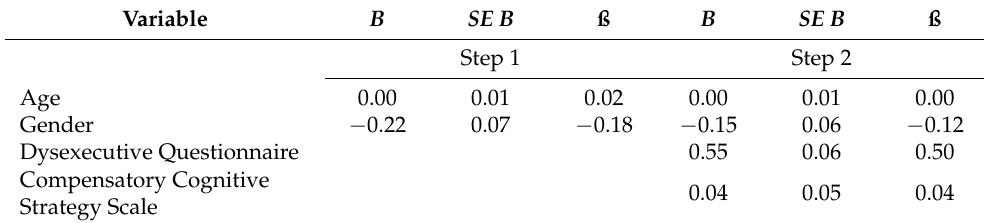
Table 4. Stepwise regression: Predicting TOPS.